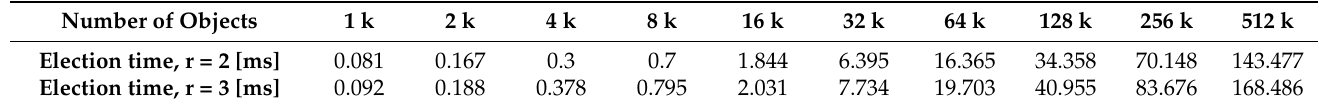
Table 1. Duration measured for the election of new masters for unavailable